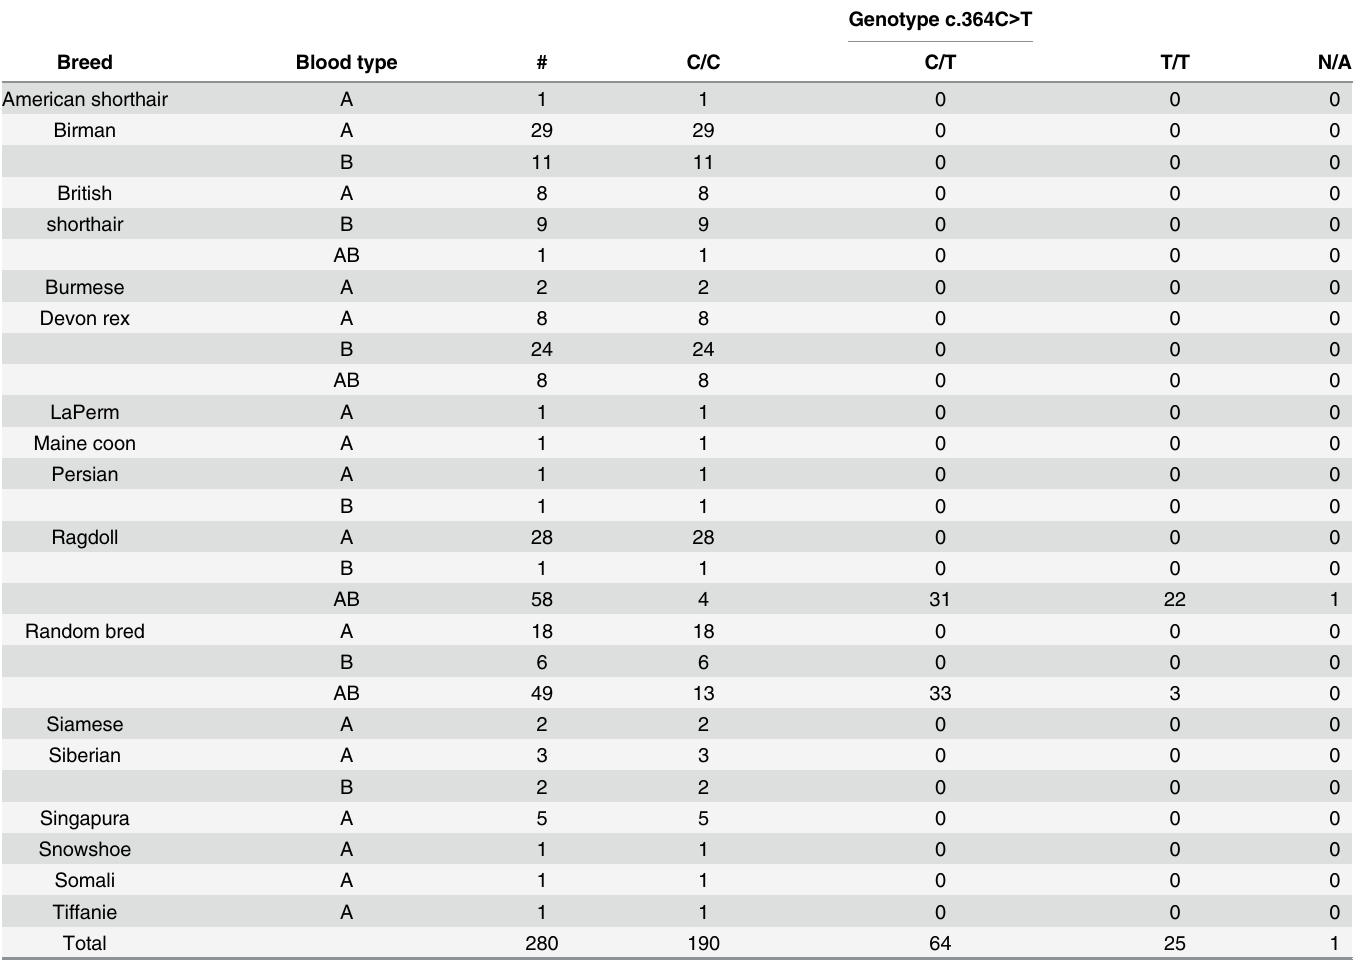
Table 2. Domestic cats with known blood type serology genotyped for the c.364C > T variant in CMAH exon